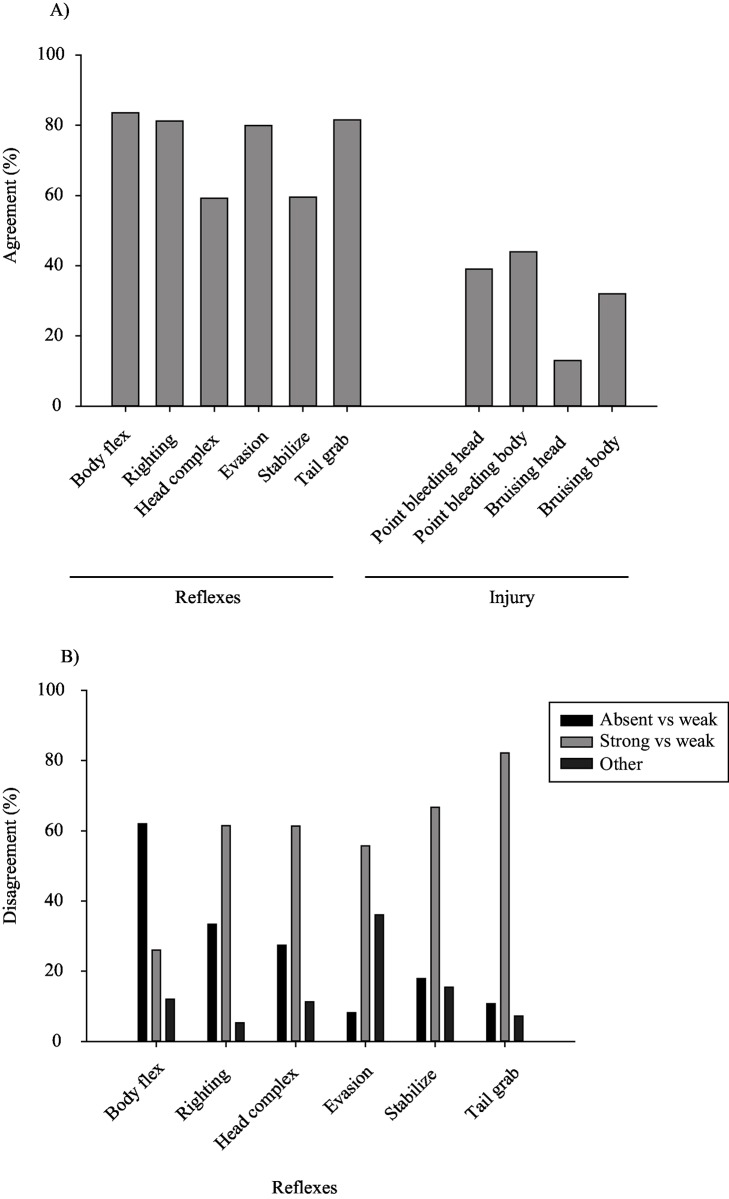
Rater (dis)agreement of categorical scores.(A) Proportion (%) of rater agreement between categorical reflex and injury scores. (B) Disagreement was apportioned into differences between the categories absent and weak (black), strong and weak (light grey) and other differences (such as between the categories absent and strong or every rater appointed another category; dark grey).